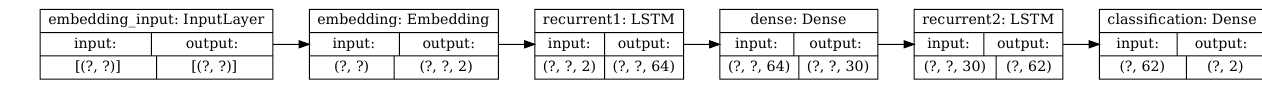
Figure 3. Sketch of the architecture used for Tomita’s 5th grammar and its variant.